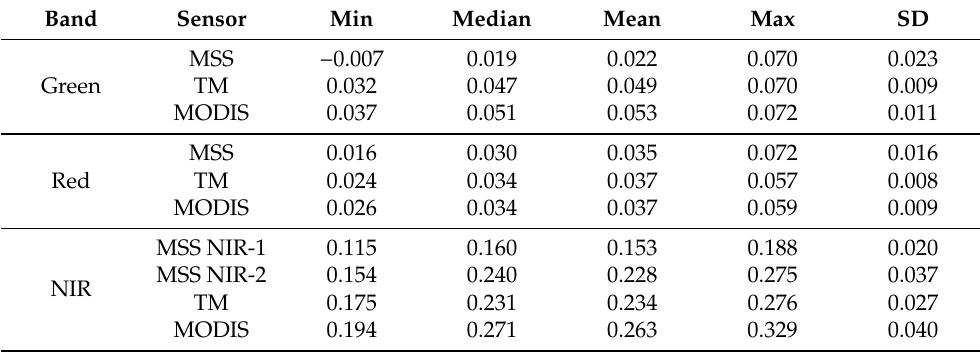
Table 11. Statistics of time-series reflectance of MSS, TM, and MODIS in ROI 4 (ROI 4: vegetation). Band Sensor